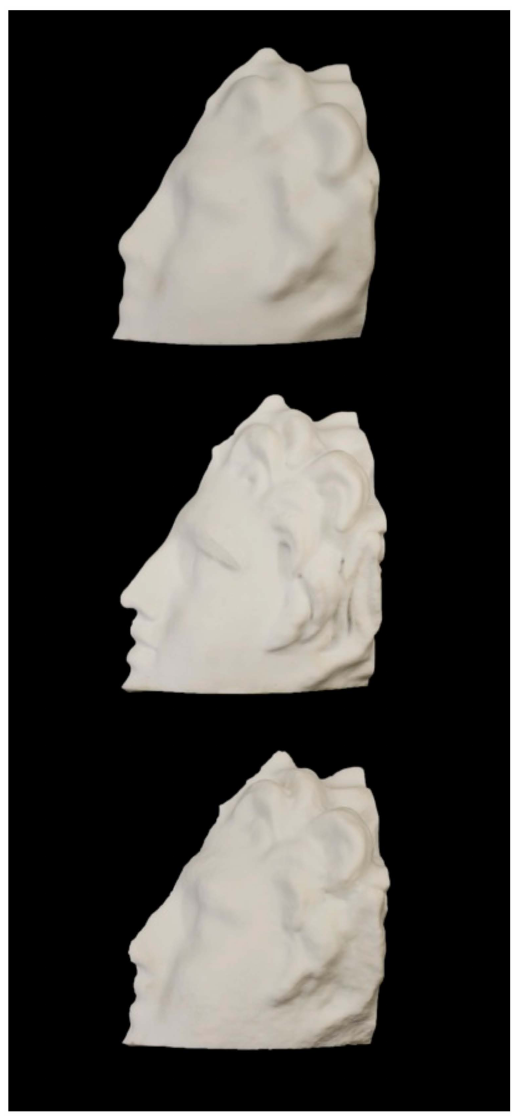
Figure 13. The three printed replicas: from above, first photogrammetry, laser-scanning, and second